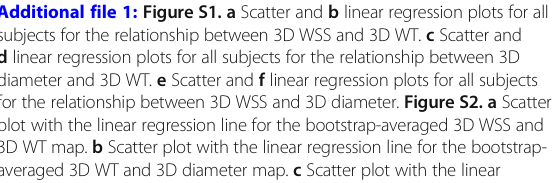
Additional file 1: Figure S1. a Scatter and b linear regression plots for all subjects for the relationship between 3D WSS and 3D WT. c Scatter and d linear regression plots for all subjects for the relationship between 3D diameter and 3D WT. e Scatter and f linear regression plots for all subjects for the relationship between 3D WSS and 3D diameter. Figure S2. a Scatter plot with the linear regression line for the bootstrap-averaged 3D WSS and 3D WT map. b Scatter plot with the linear regression line for the bootstrap- averaged 3D WT and 3D diameter map. c Scatter plot with the